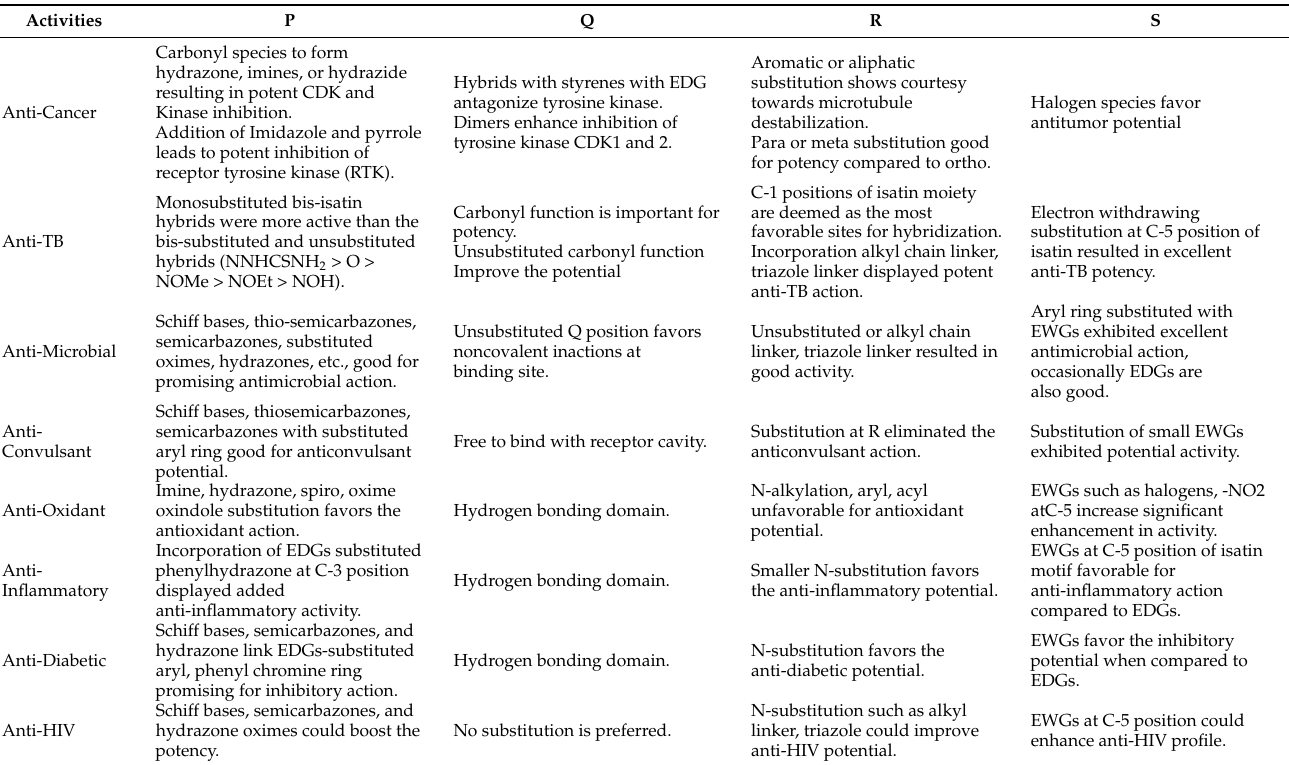
Table 1. Summary of SAR analysis for potential